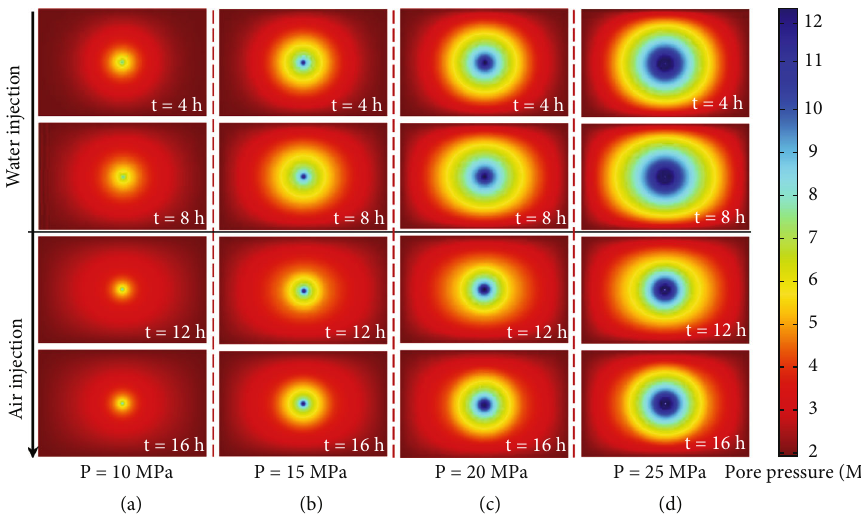
Figure 17: Contour of pore pressures under di ff erent injection